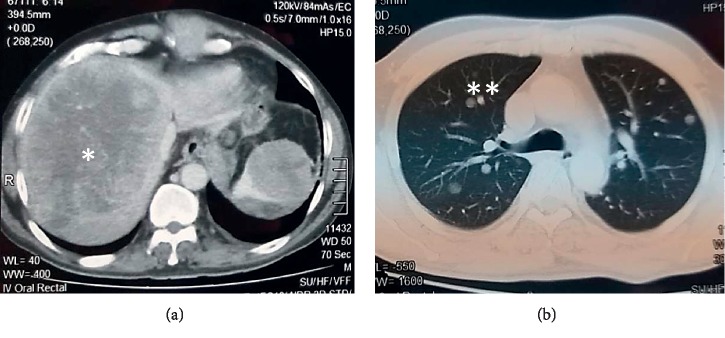
CECT chest and abdomen (axial image): large liver metastasis∗ (largest: 12 × 11 cm in segment VII and VIII) and lung metastases∗∗.